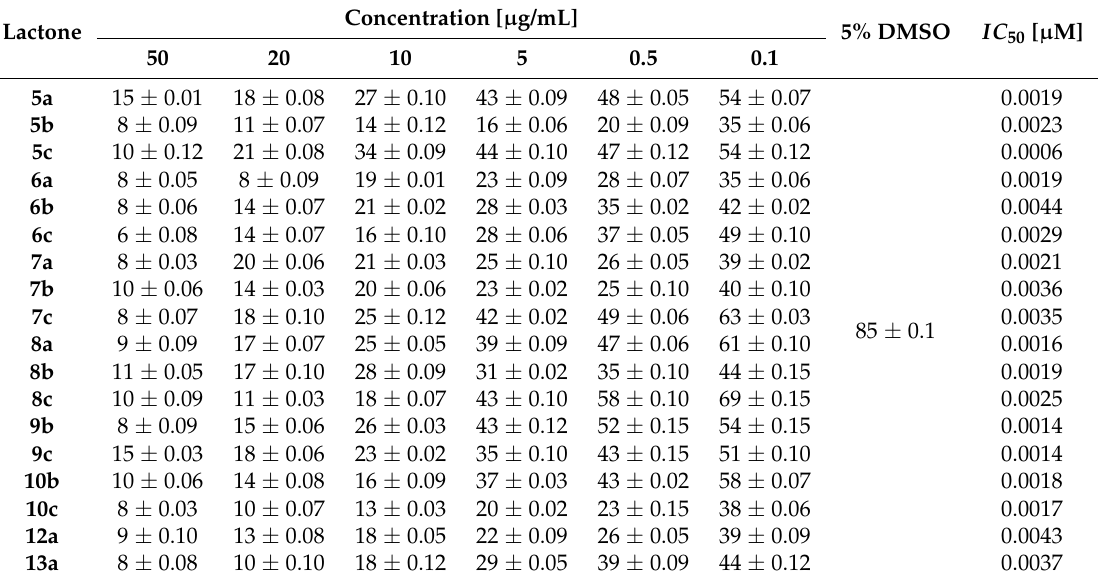
Table 4. The cytotoxic activity of tested lactones against AGS cell lines.